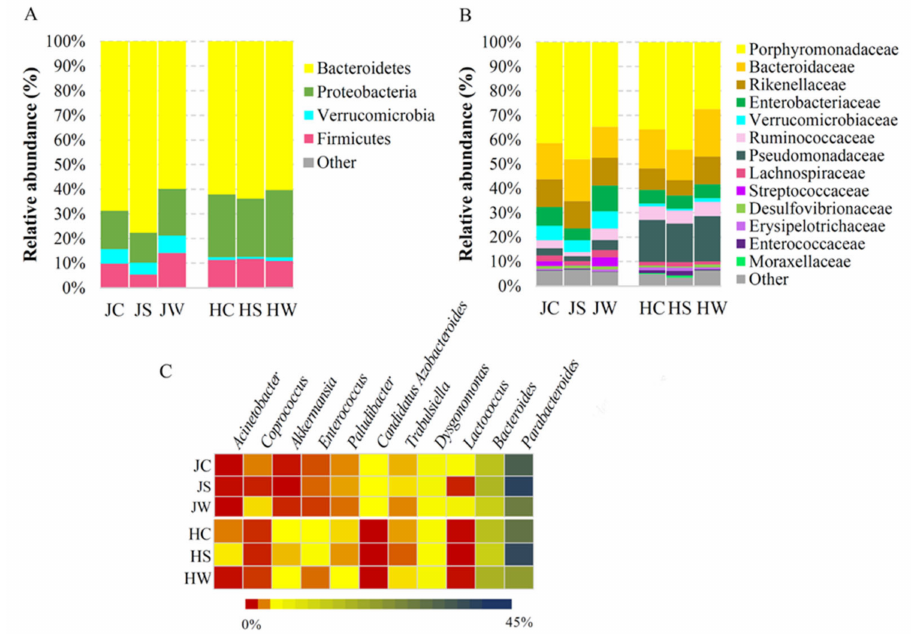
Figure 2. Taxonomic composition of Jamaican and house cricket’s microbiota. Relative abundance of ASVs at phylum ( A ) and family ( B ) level. Heatmap ( C ) demonstrates most abundant ASVs at genus level. JS—Jamaican cricket surface, JW—Jamaican cricket whole-body, JC—combined surface and whole-body samples of Jamaican crickets. HS—house cricket surface, HW—house cricket whole-body, HC—combined surface and whole-body samples of house